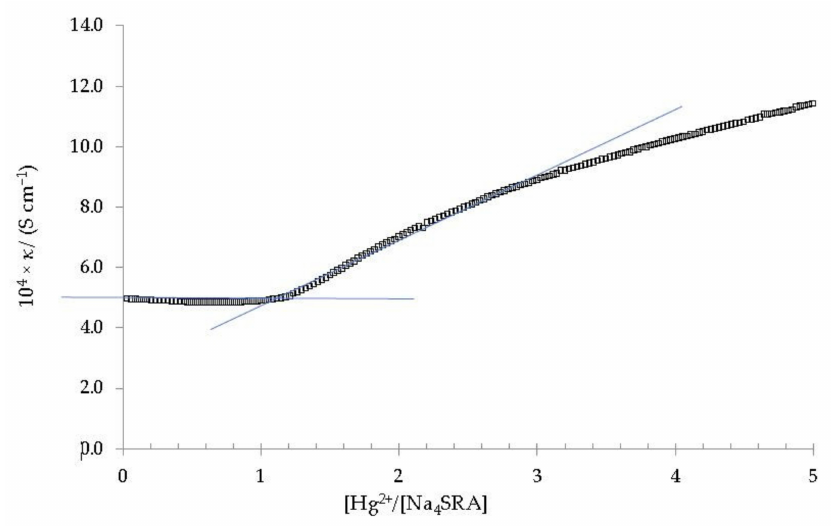
Figure 7. Specific conductivity versus the [Hg 2+ ]/[Na 4 SRA] ratio. The solid blue lines are shown as a visual aid to indicate the cut-off point that relates the change in slope of the specific conductivity with respect to the stoichiometry of the complex.